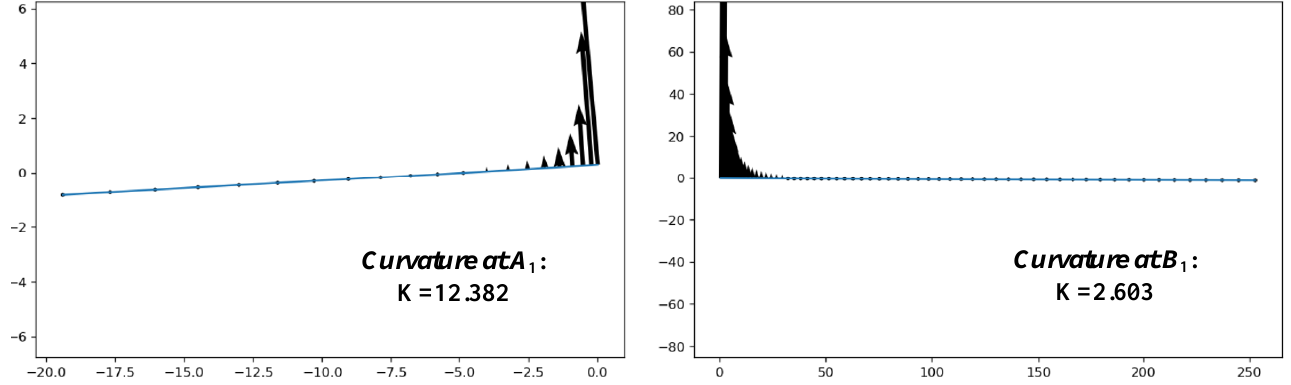
Figure 14. Apple bottom curvature. According to the above statistics and analysis results, pickers should adapt to most deflection angles, while effectively picking most graspable apples [26]. In Section 2.3, the